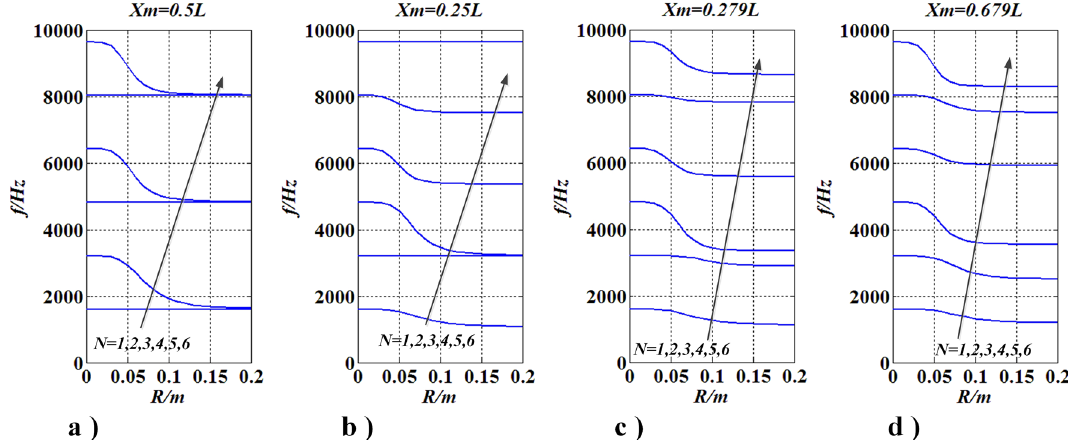
Figure 15. Changes of frequencies with R ( J m ) and x m = constant (This figure was created via Visio 2013 and Matlab 2015, Figs. 22, 23 were created by them too).